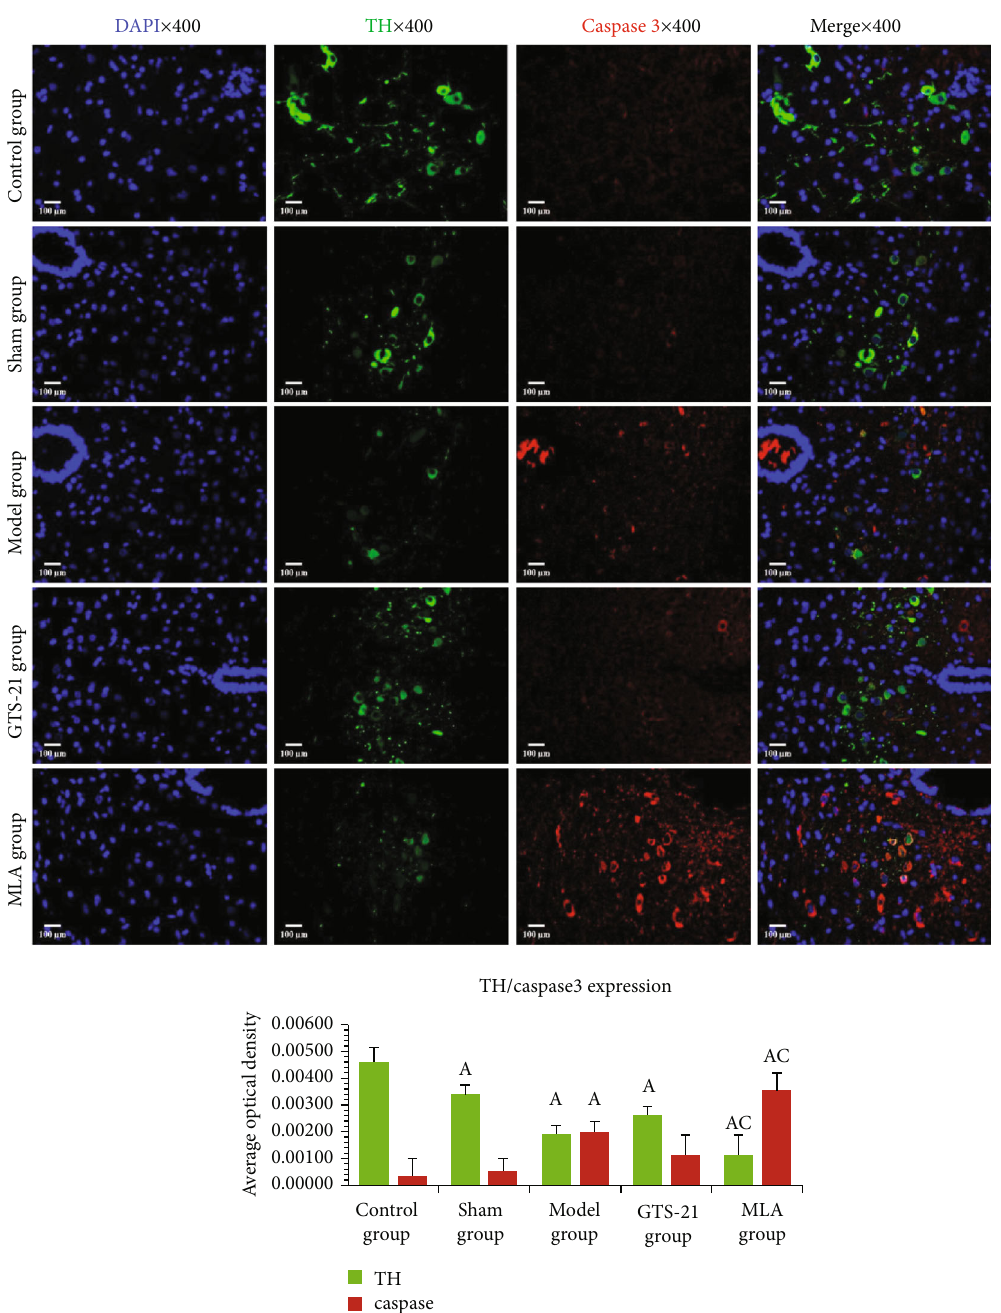
Figure 7: Catecholaminergic neuron apoptosis in MVZ among di ff erent groups. The images mainly cover the NST and VLRN of MVZ. DAPI: 4 ′ ,6-diamidino-2-phenylindole, a fl uorescent blue dye capable of binding strongly to DNA. TH: tyrosine hydroxylase, used for labeling catecholaminergic neurons (stained green with FITC); Caspase3: indicator for apoptotic cell (stained red with Cy3). The scale bars at the bottom left of the images represent 100 μ m. a: P < 0 : 05 vs. control group; c: P < 0 : 05 vs. GTS-21